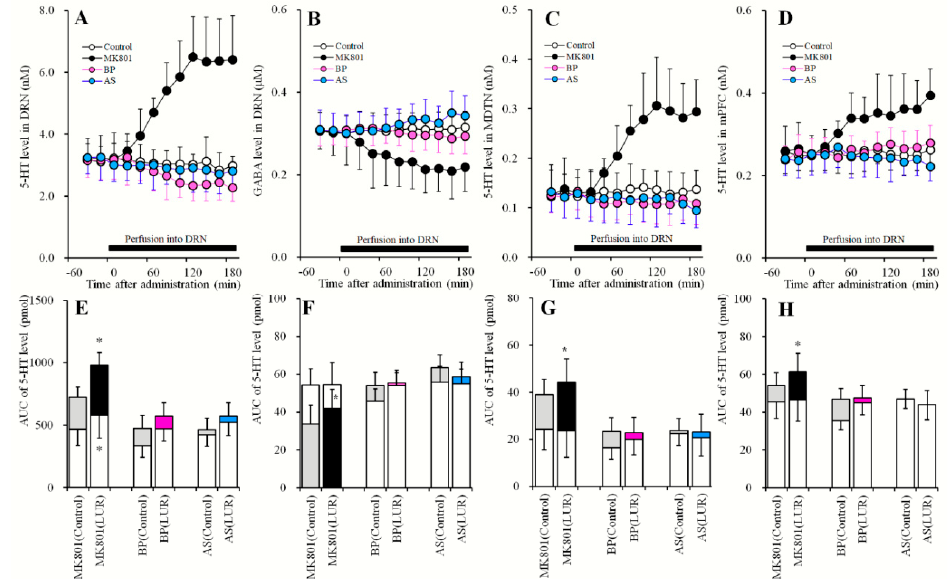
Figure 7. Effects of local administration of MK801, BP554 and AS19 into the DRN on 5-HT releases in the DRN, MDTN, mPFC, and GABA in the DRN, after sub-chronic administration of lurasidone (Study_6). ( A , C , D ) indicate e ff ects of perfusion with MK801 (5 µ M), BP554 (BP: 50 µ M) and AS19 (AS: 1 µ M) into the DRN on extracellular levels of 5-HT in the DRN, MDTN and mPFC, respectively, after the sub-chronic administration of e ff ective dose of lurasidone (3 mg / kg / day for 7 days). ( B ) indicates e ff ects of perfusion with MK801, BP554 and AS19 into the DRN on extracellular GABA level in the DRN, after sub-chronic administration of e ff ective dose of lurasidone. Y -axis: Mean ± SD (n = 6) of extracellular levels of 5-HT (nM) and GABA ( µ M); X -axis: Time after administration of target agents (min). Closed bars indicate perfusion with target agents into the DRN. Microdialysis was conducted to measure the releases of 5-HT and GABA. ( E – H ) indicate the AUC value of extracellular levels of 5-HT (pmol) and GABA (nmol) during perfusion with MK801, BP554 or AS19 from 20 to 180 min. Opened columns indicate the AUC values of pre-perfusion of target agents in Figures 4 and 7. Gray columns indicate the AUC values of during perfusion with target agents (MK801, BP554 and AS19) in Figure 4. Closed, pink and light blue columns indicate AUC values of during perfusion with target agents (MK801, BP554 and AS19) in ( A – D ), respectively. * P < 0.05; relative to control (without sub-chronic lurasidone administration) by MANOVA with Tukey’s post hoc